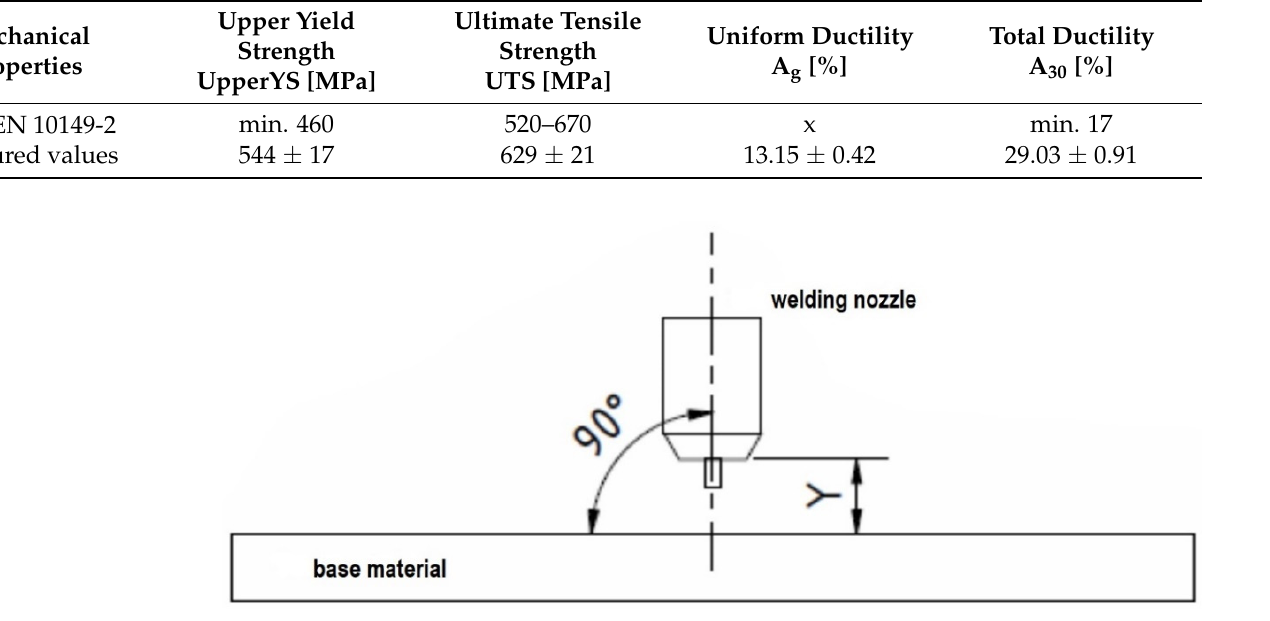
Figure 3. Adjustment of welding nozzle adjustment regarding the base material.